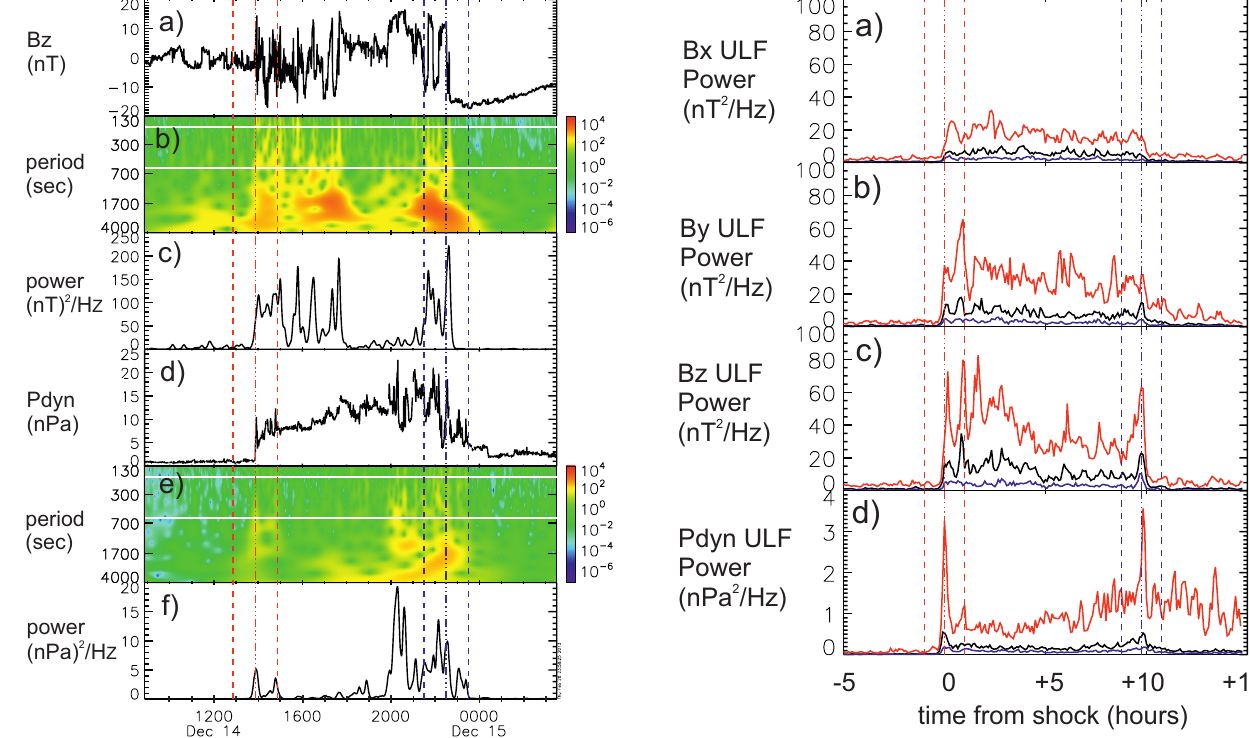
Fig. 3. The results of the superposed epoch analysis of the 41 stud- ied events. The curves show the median (black), and the upper (red) and lower (blue) quartiles for ULF power in (a) B X , (b) B Y , (c) B Z , and (d) P dyn fluctuations. The red dash-dotted line shows the shock, and the blue dash-dotted line the leading edge. The 1h (non-stretched) regions adjacent to the shock and the leading edge are bounded by the pairs of dashed